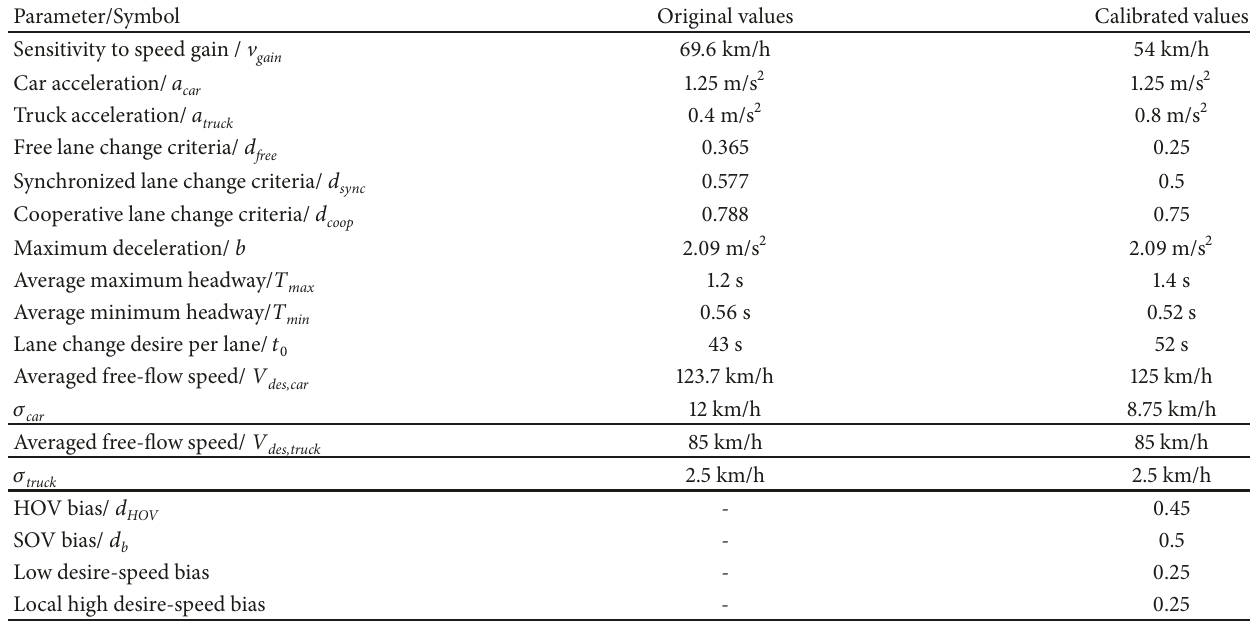
Table 2: Calibrated MOTUS parameters of the SR99